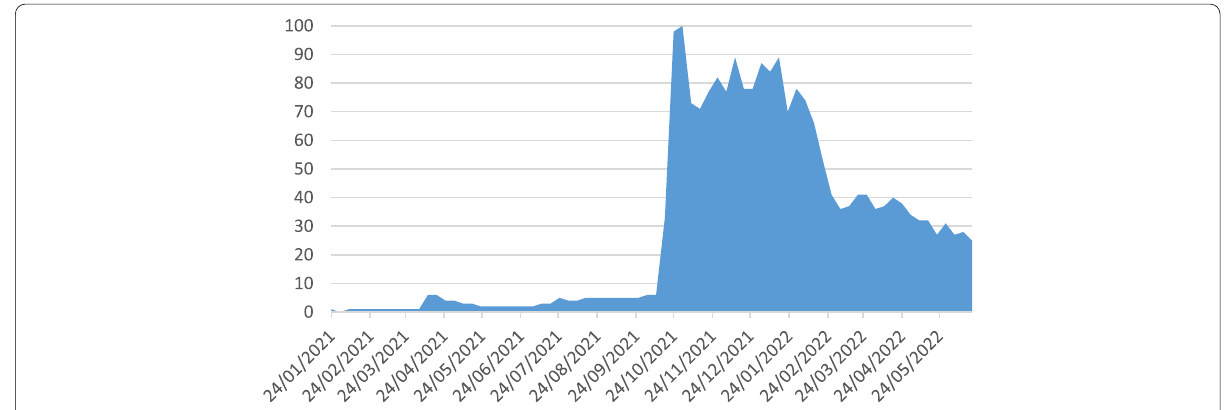
Fig. 3 Stats on worldwide Google Search interest of the metaverse, in percents